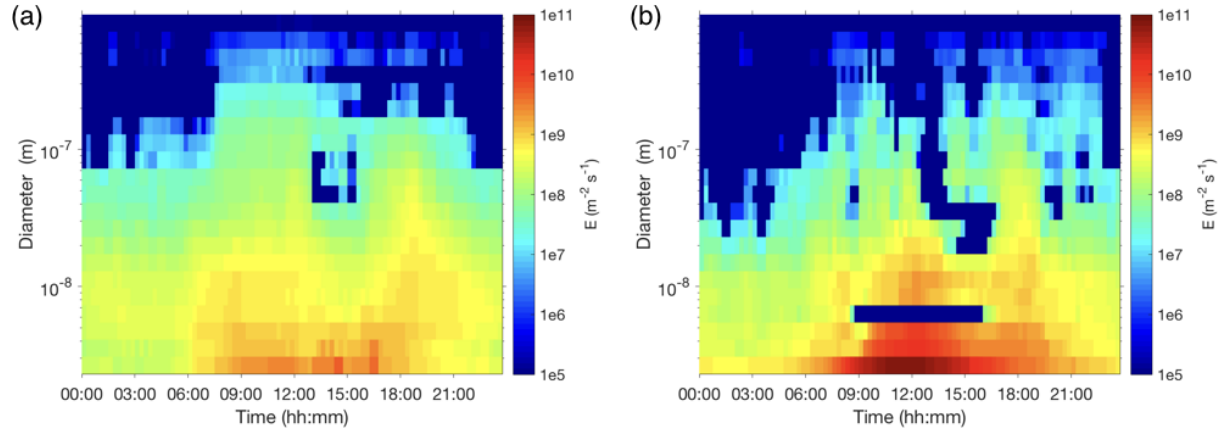
Figure 4. Average diurnal variation in particle number emission size distributions (a) on days without NPF events and (b) on NPF event